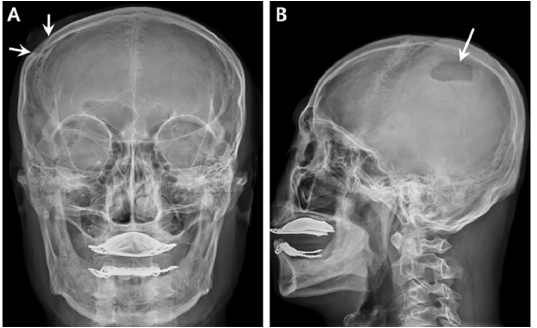
Figure 1. Frontal ( A ) and lateral ( B ) skull radiographs showing a well-circumscribed, oval, osteolytic lesion in the right parietal bone (arrows) with incomplete marginal sclerosis and overlying scalp swelling.